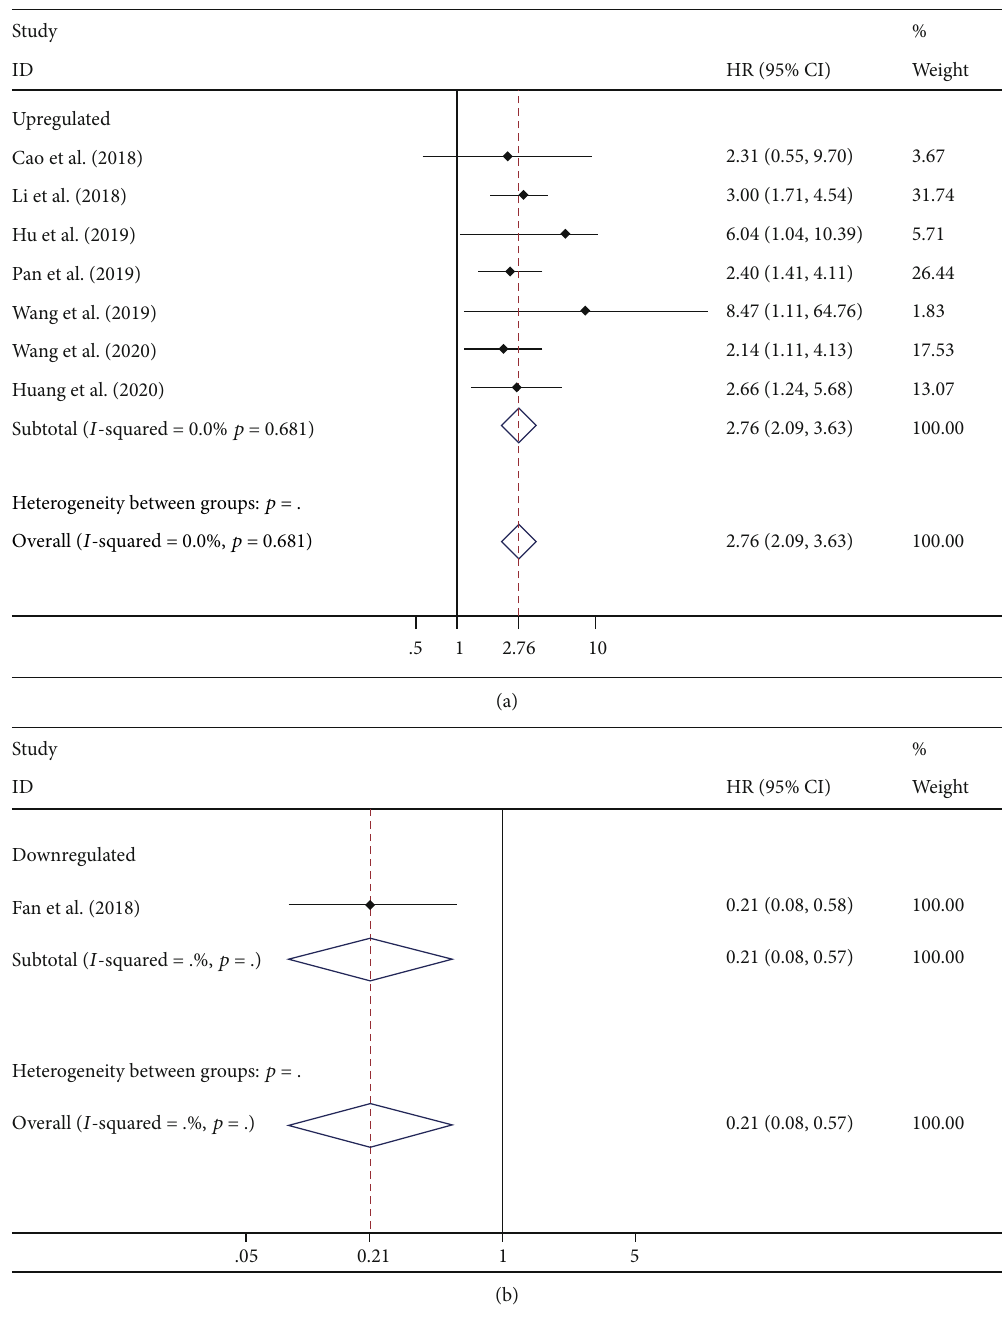
Figure 6: Forest plots to demonstrate that the aberrant expression of circRNAs was correlated with poor overall survival (OS) prognosis: (a) tumor-promoter circRNAs; (b) tumor-suppressor circRNAs. circRNAs, circular